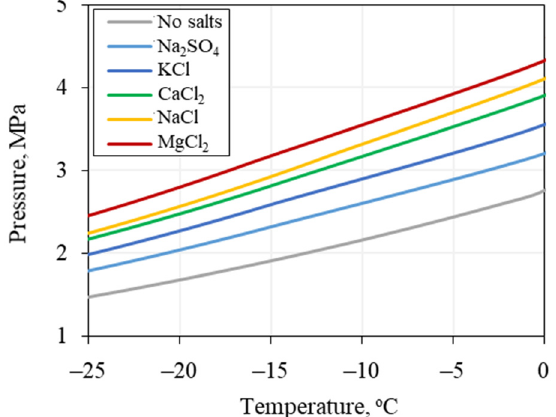
Figure 12. Pressure and temperature conditions of pore hydrate stability in frozen sand interacting with 5% Na 2 SO 4 , KCl, CaCl 2 , NaCl, and MgCl 2 solutions, at temperatures from 0 °C to − 20 °C (HydraFlash modeling).